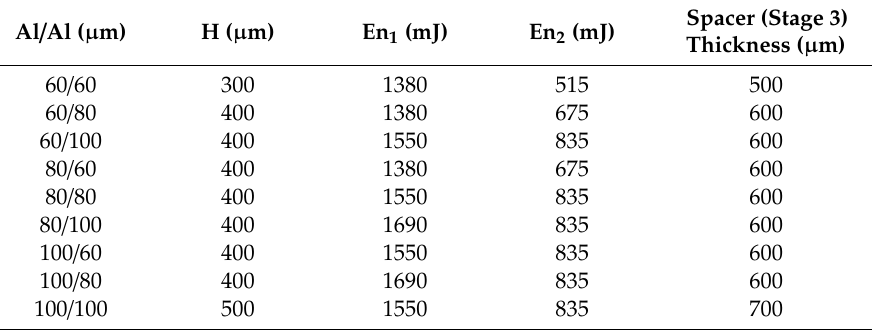
Table 9. Process parameters for di ff erent tested Al / Al